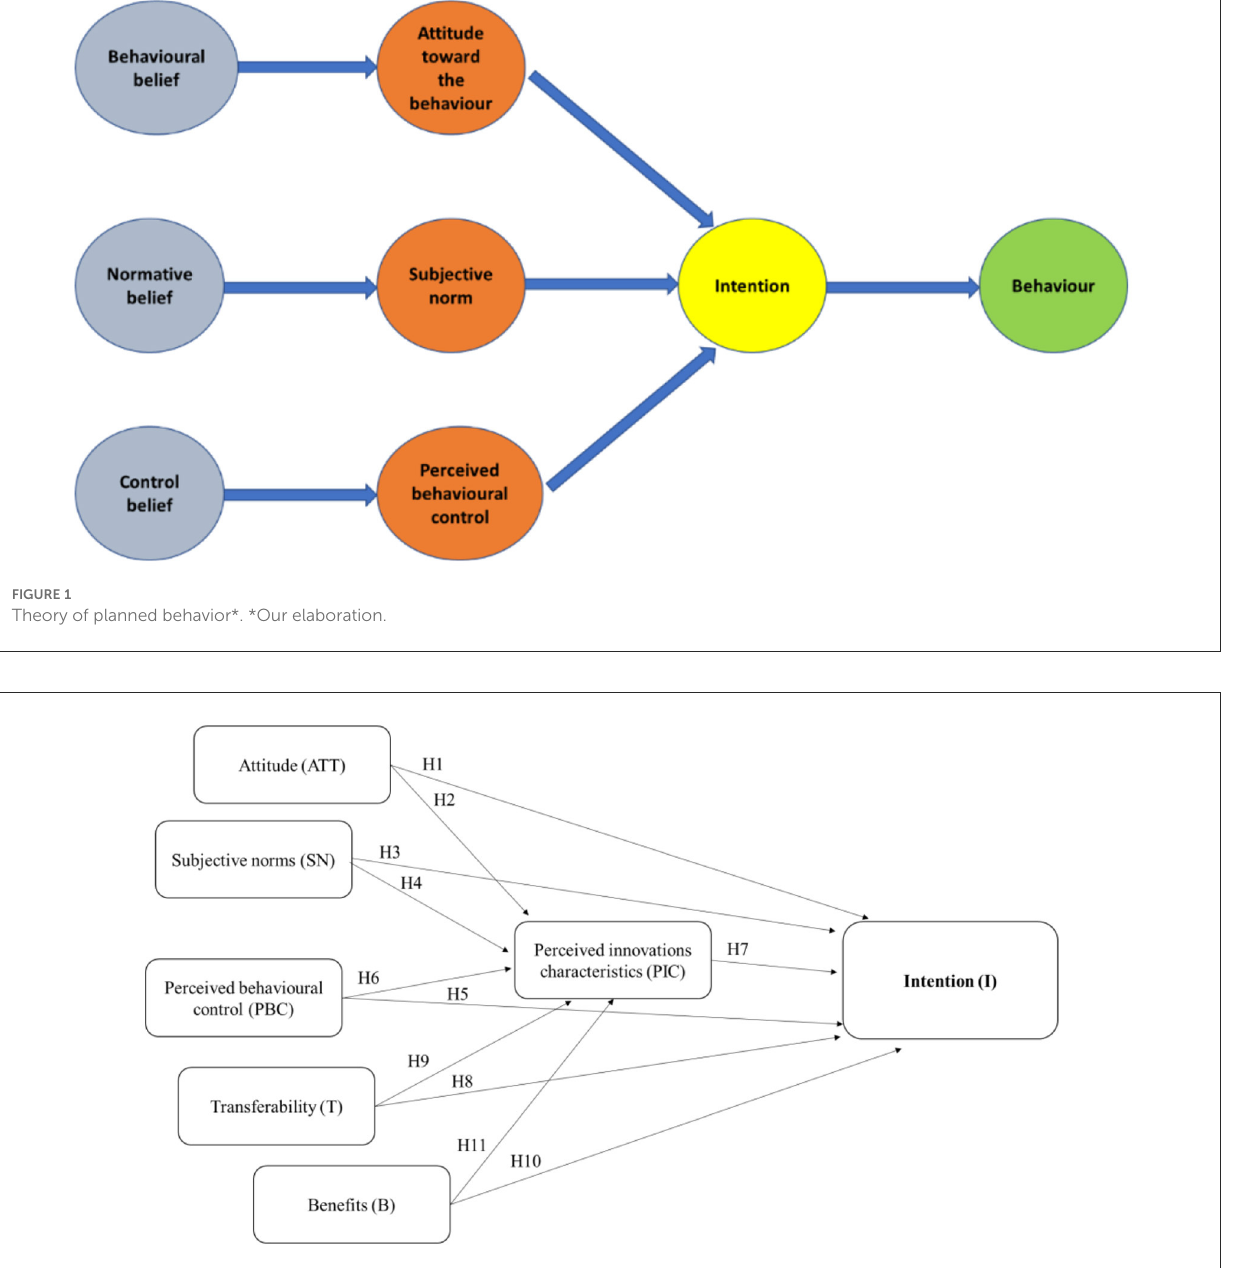
link between the other factors and intention (Figure